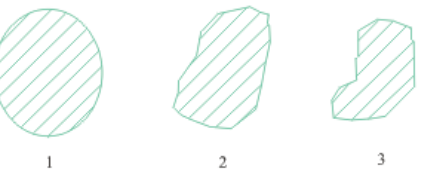
Figure 3. The morphology of Karst depressions for different Karst stages 1, 2, and 3 represent three Karst development stages from strong to weak degree.